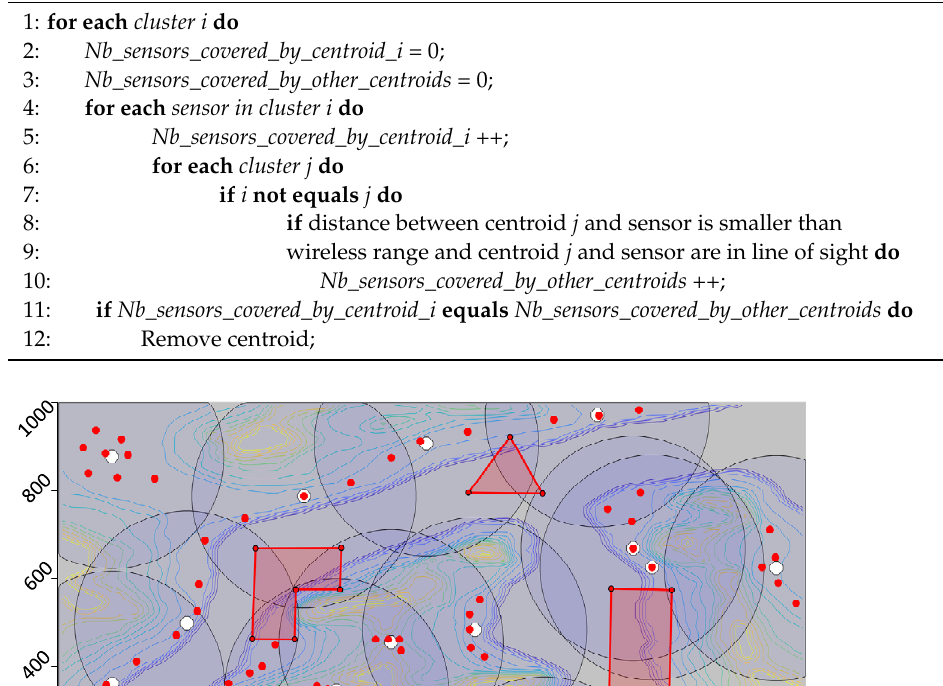
Algorithm 2. Removal of extra download points